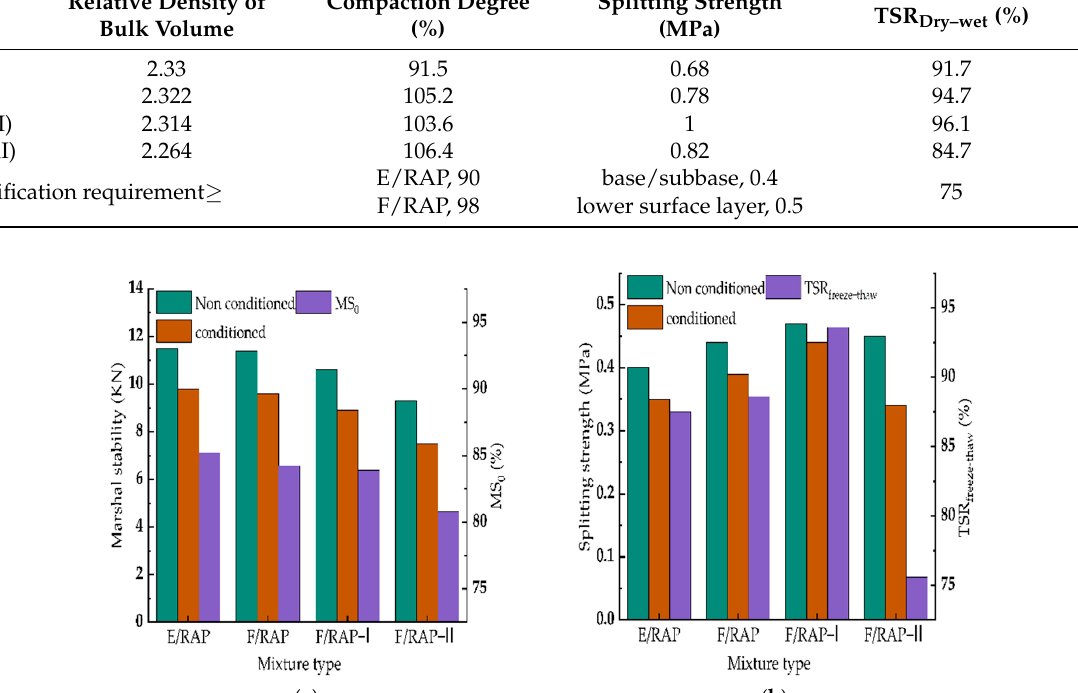
Table 5. Dry–wet ITS results of core specimens from construction field.